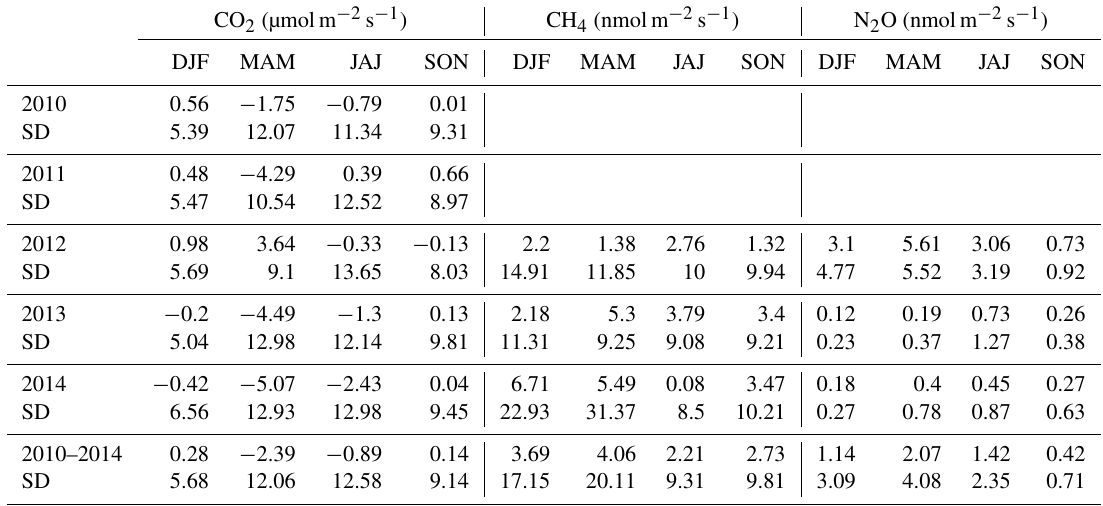
Table 3. Average GHG flux rates per season: winter (DJF), spring (MAM), summer (JJA) and fall (SON). Values are based on gap-filled data to avoid bias from missing nighttime data (predominantly relevant for CO 2 ). Data are only presented when continuous measurements (eddy covariance data) were available. Sign convention: positive values denote export or release and negative values import or